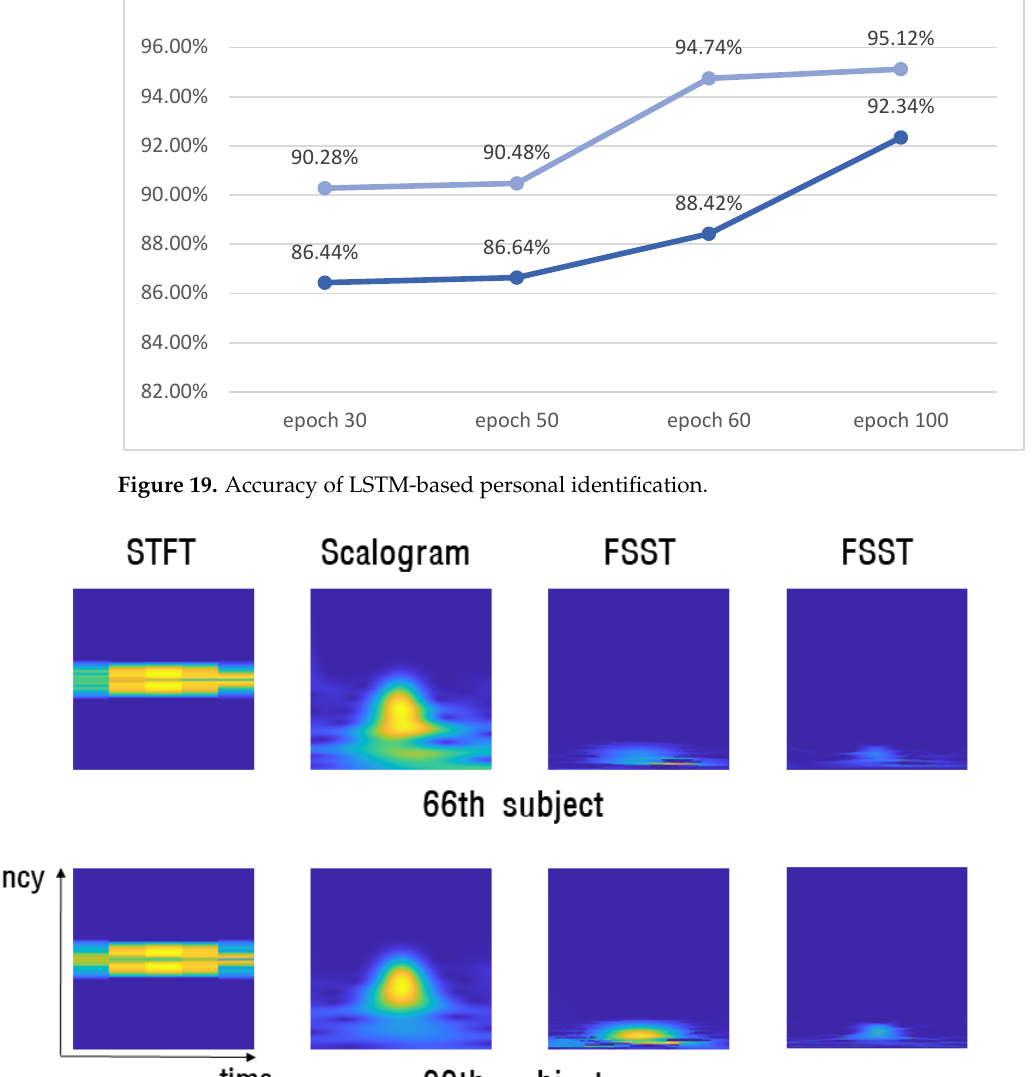
Figure 20. Time – frequency representation of a subject with regard the CU-ECG database signal. Figure 20. Time–frequency representation of a subject with regard the CU-ECG database